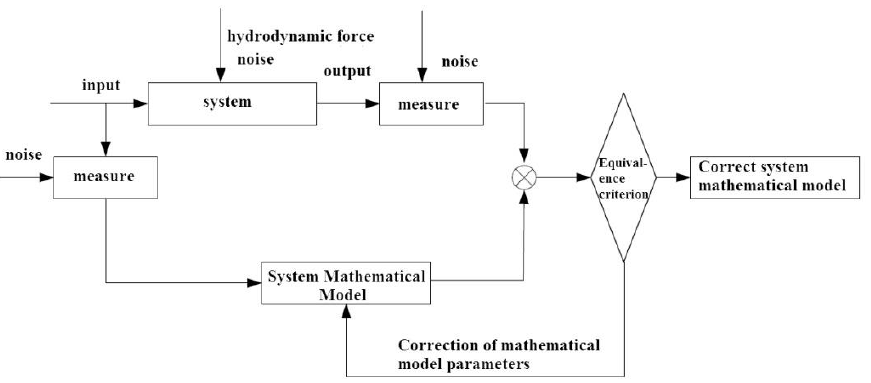
Figure 4. Frame-diagram of identification.